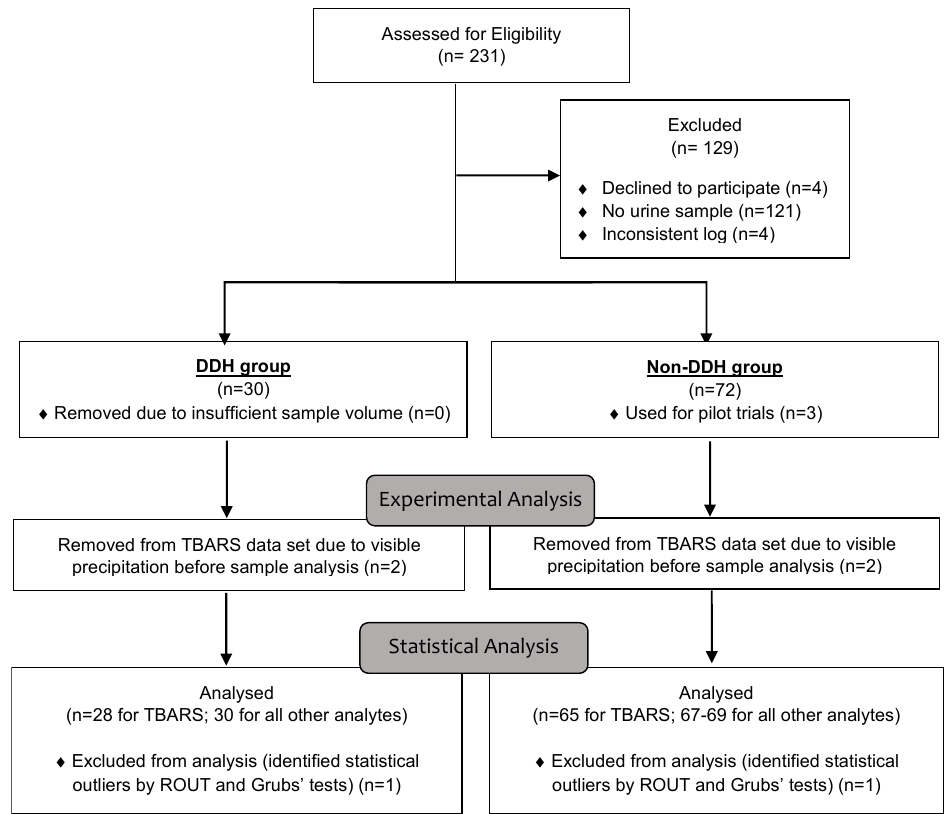
Figure 1. Flow chart demonstrating inclusion/exclusion criteria .